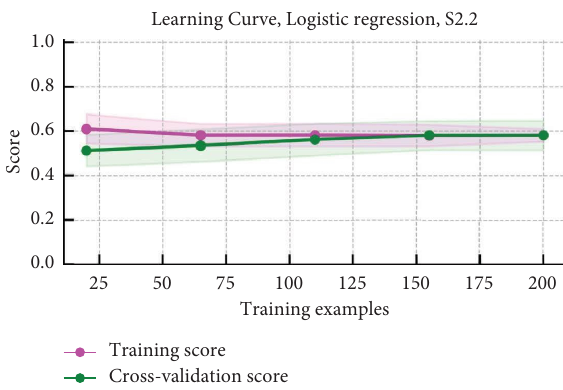
Figure 5: Learning curve for logistic regression model.